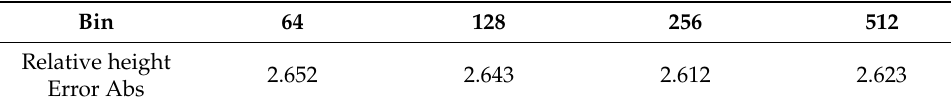
Table 5. Different bin of experimental